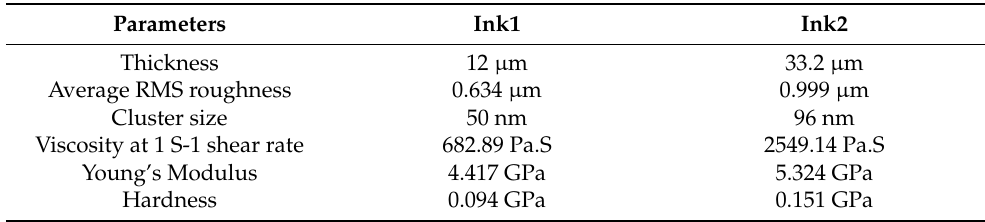
Table 1. Characteristics of Ink1 and